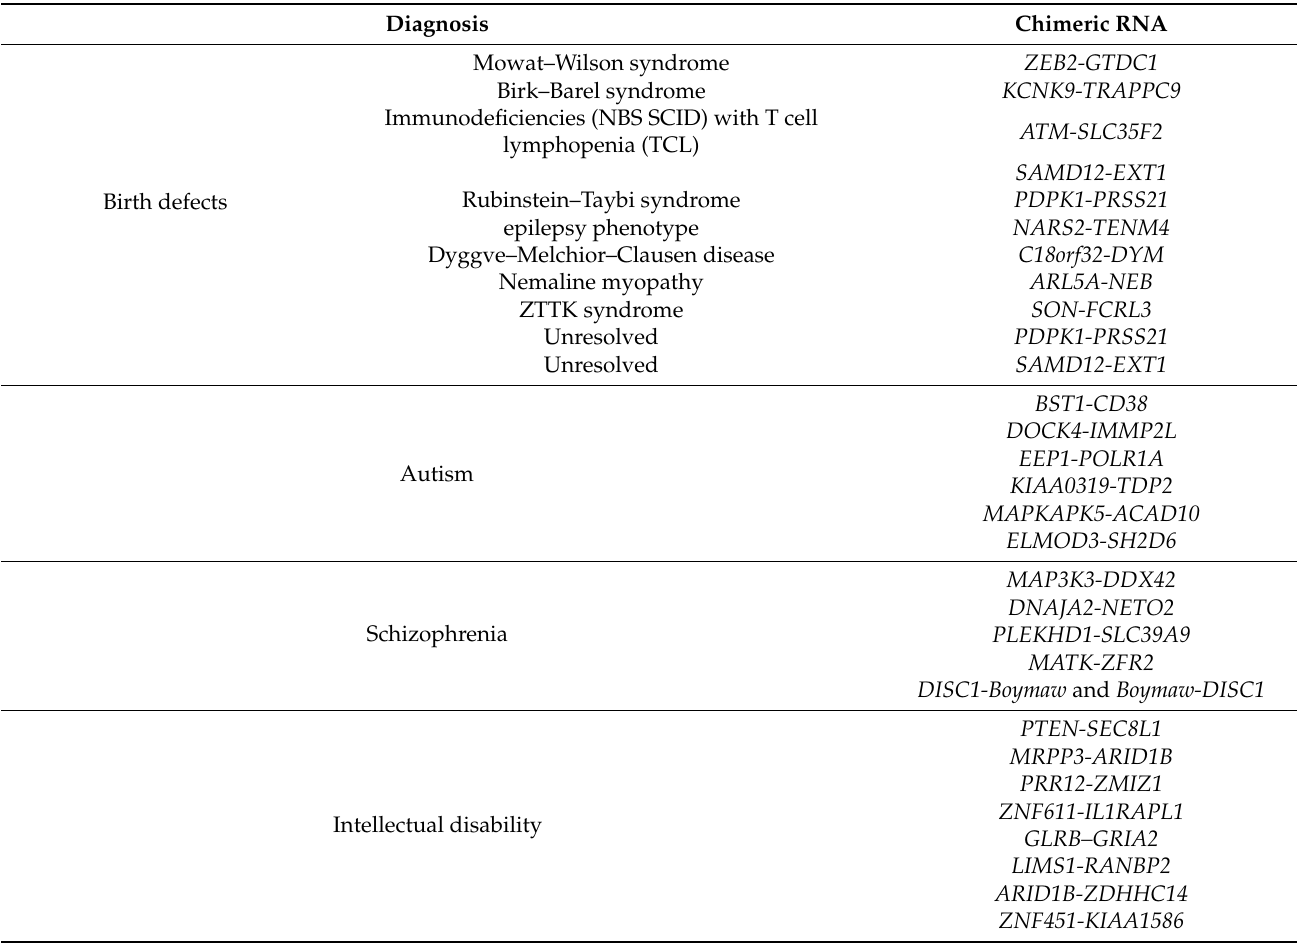
Table 2. Chimeric RNAs in other types of genetic diseases and psychological